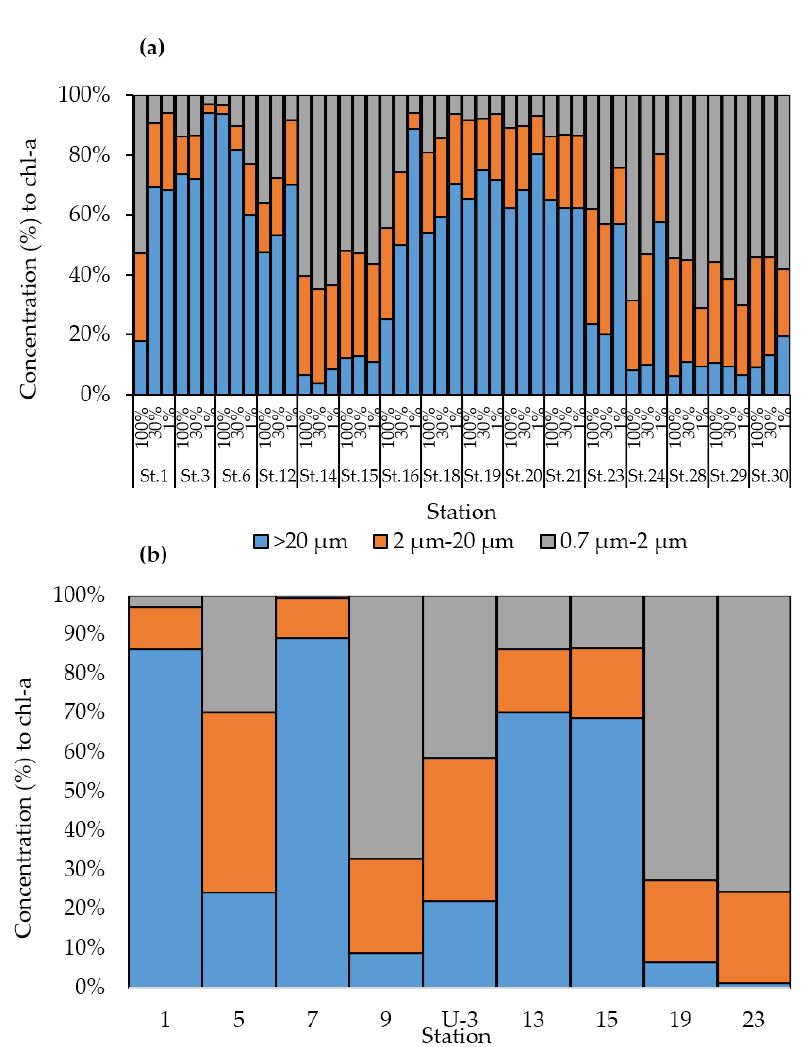
Figure 4. Total chlorophyll- a concentration of ( a ) ARA07B and ( b ) OS040.